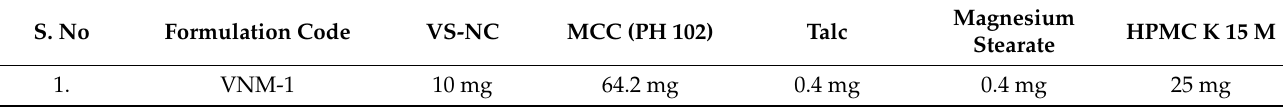
Table 6. Formulation of VNM.